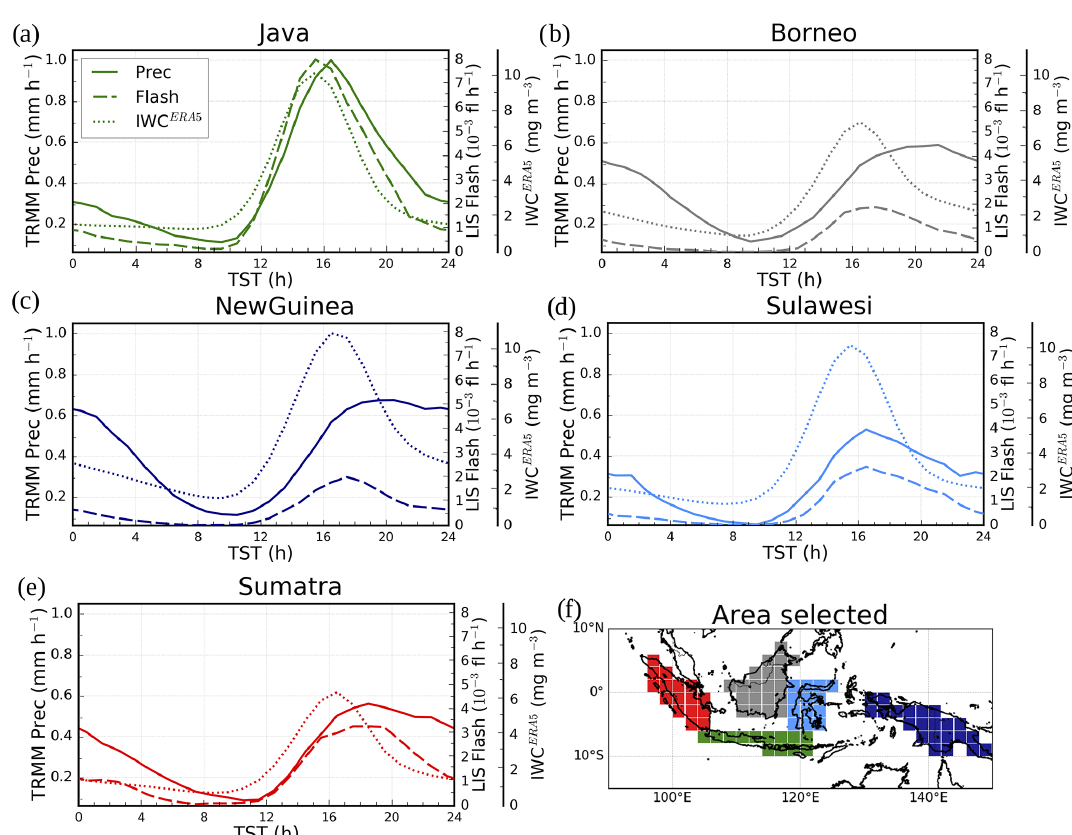
Figure 8. Diurnal cycles of Prec (solid line), Flash (dashed line) and IWC ERA5 from ERA5 at 150hPa (dotted line) over MariCont islands: Java (a) , Borneo (b) , New Guinea (c) , Sulawesi (d) and Sumatra (e) and map of the study zones over land (f) .